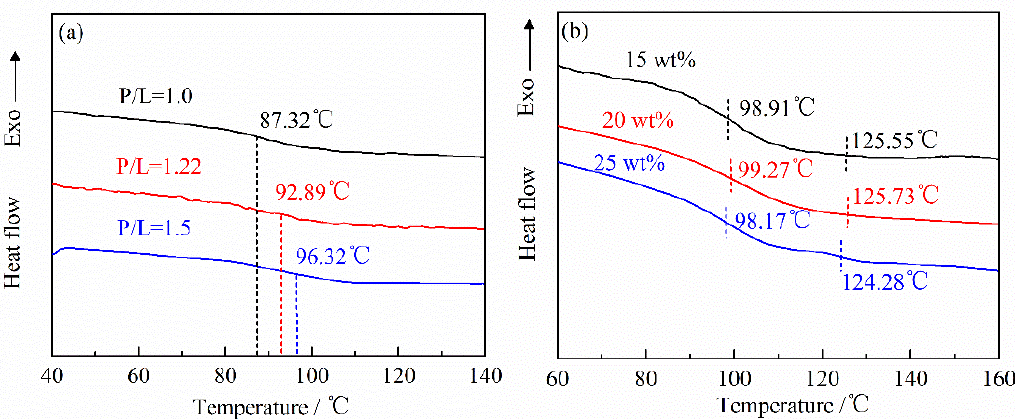
Figure 4. Differential scanning calorimetry (DSC) curves of ( a ) the unfilled PMMA synthesized by the different P/L ratios and ( b ) PTFE/PMMA composites (P/L = 1.5) and pure PTFE.